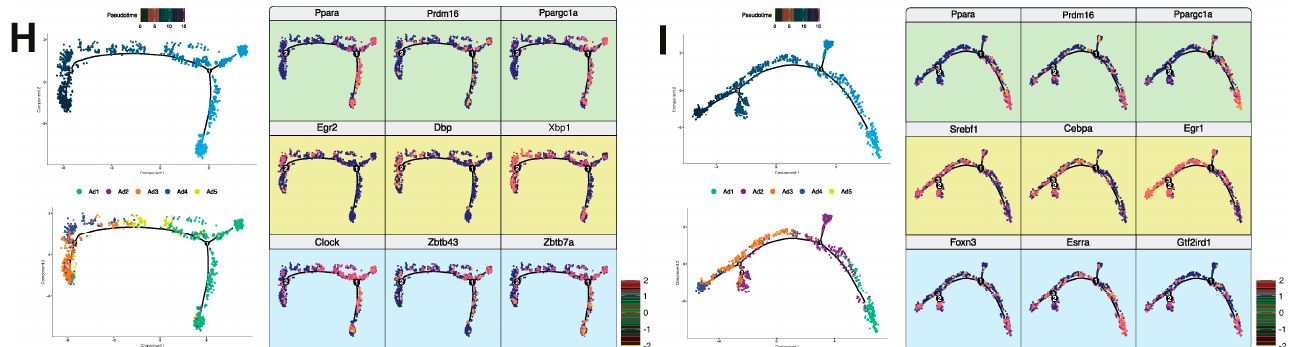
Figure 3. CL treatment and cold-challenge reveals a single thermogenic subpopulation. ( A ) t -SNE representation showing a subset of mature adipocyte nuclei subclusters classified according to each treatment (Cold = 892 cells: CL = 1433 cells and RT = 702 cells). ( B ) Nebulosa expression plots of canonical mature adipocyte and thermogenic genes. ( C ) Gene Set Enrichment Analysis (GSEA) comparing Cold vs. RT and CL vs. RT. Rows depict enriched pathways, while on the y-axis, the Normalized Enrichment Score (NES). Positive NES represents an upregulated pathway, and negative NES represents down-regulated pathways. ( D ) CL, RT, and Cold shown subset of adipocyte nuclei subclusters classified according to each treatment integrated in t -SNE plot (CL = 1443 cells; RT = 702 cells and Cold = 892 cells). Pie charts show the corresponding percentage. ( E ) Heat map showing the expression of main genes related to fatty acid oxidation, tricarboxylic acid cycle, fatty acid transport, glycolytic process, triglyceride/fatty acid cycle, and de novo lipogenesis in the five adipocytes subclusters. ( F ) Heat-scatter plot representing top five upregulated membranome components specifically identified in Ad1 subcluster and the top five exclusive membranome of Ad5 subcluster from CL subset comparison. The top five membrane genes from subcluster Ad2 (Cold) are demonstrated separately (left). A heat-scatter plot representing the top five upregulated secretome components specifically identified in Ad1 subcluster and the top five exclusive secretome of Ad5 subcluster. The top five secretome genes from subcluster Ad2 (Cold) are demonstrated separately (right). The color of the circles corresponds to the average logFC. FC: fold change ( G ) Scatter-box plot representing normalized gene expression of 20 markers of canonical adipocyte and thermogenic genes in the five adipocyte subclusters. At the top of each box is the significance. ns, non-statistical significance, * p < 0.05, ** p < 0.01, *** p < 0.005, **** p < 0.0001. ( H ) Monocle-generated plots presenting pseudotime ordering and differentiation trajectory of CL and RT conditions. The trajectory suggests a transition between Ad3-Ad4-Ad5-Ad1. Green background represents the three main thermogenic TFs (classic). The yellow background represents the earlier expressed TFs in the trajectory, and the blue background represents the later expressed TFs in the trajectory. The characterized genes are DEGs throughout the trajectory. ( I ) Monocle-generated plots presenting pseudotime ordering and differentiation trajectory of Cold and RT conditions. The trajectory suggests a transition between Ad4-Ad3-Ad2-Ad1. Green background represents the three main thermogenic TFs (classic). The yellow background represents the earlier expressed TFs in the trajectory, and the blue background represents the later expressed TFs in the trajectory. The characterized genes are DEGs throughout the trajectory.